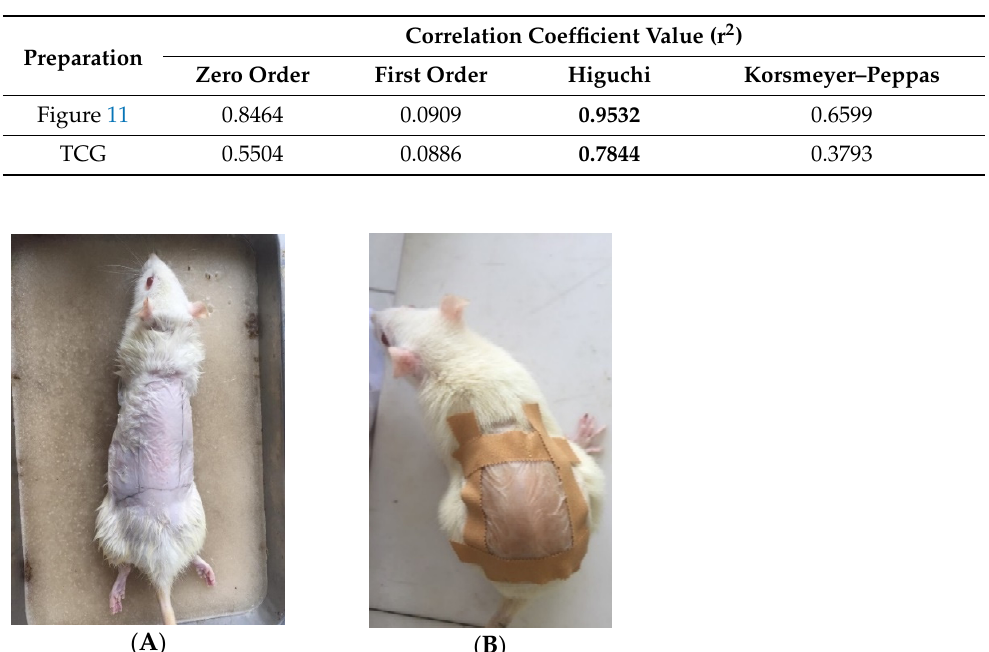
Table 5. Coefficient correlation of TCG and NTCG.